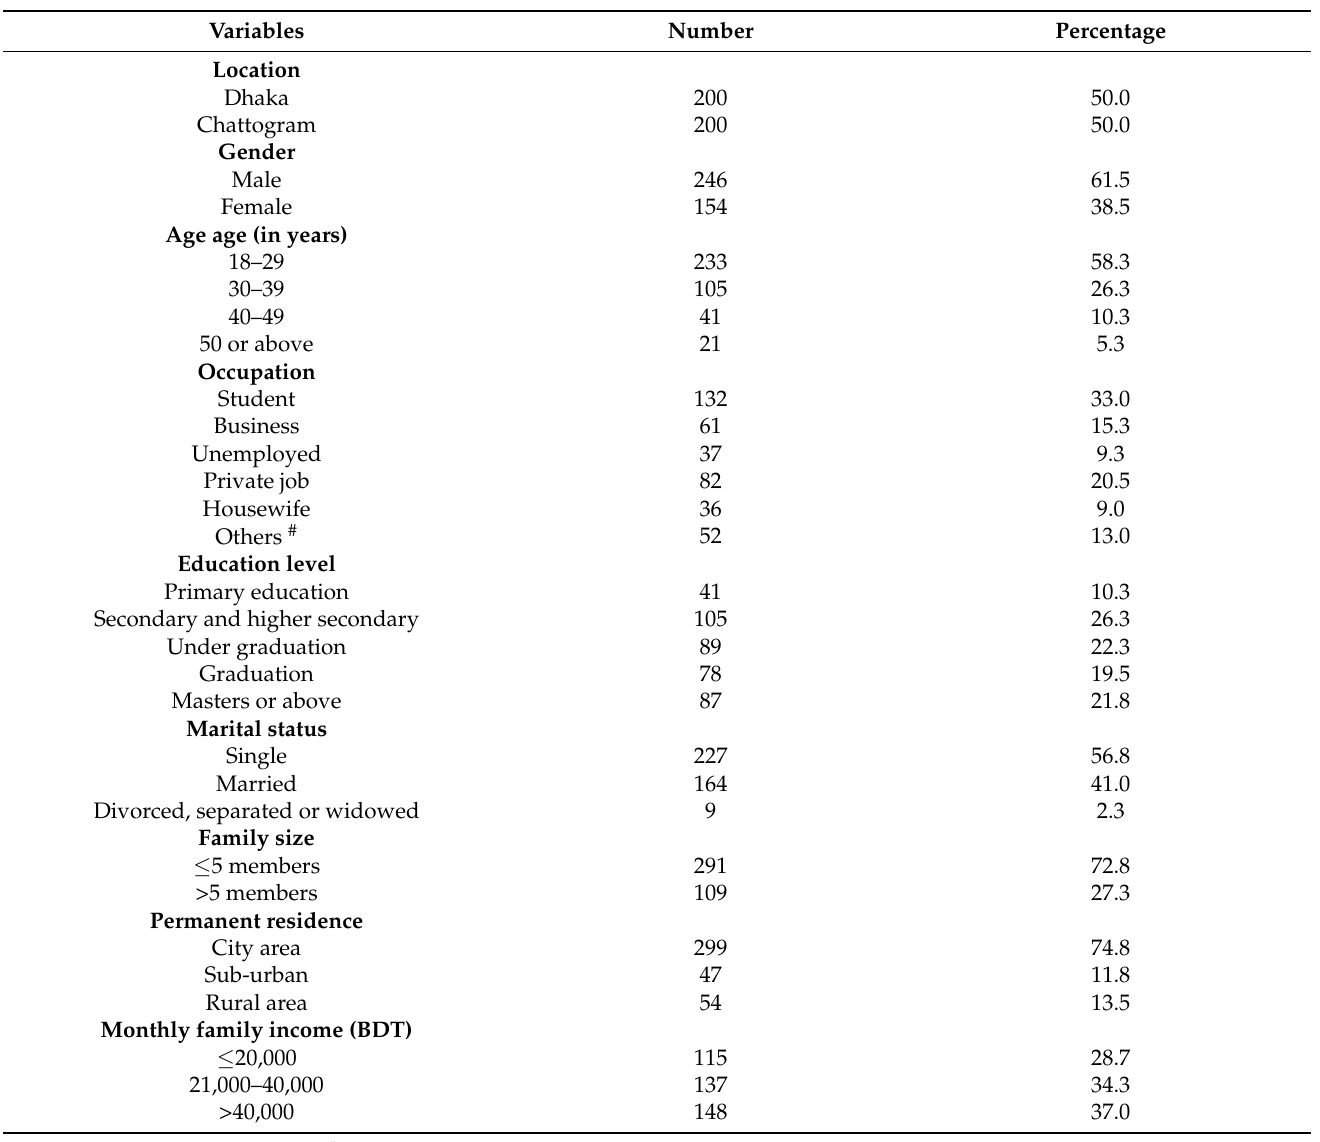
Table 1. Socio-demographic characteristics of study participants (N =